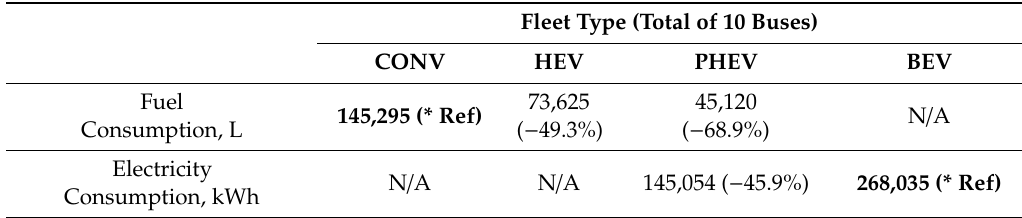
Table 5. Fuel and electricity consumption per fleet type for full five-month